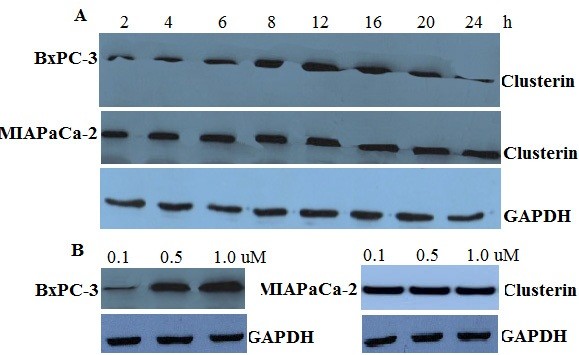
Induction of sCLU in a time and dose dependent fashion by gemcitabine treatment.A. Western analysis showing sCLU expression after 2–24 hours treatment with 0.5 nM gemcitabine. Induction of sCLU is evident in chemo-sensitive BxPC-3 cells when treated with high doses of gemcitabine but not in MIAPaCa-2, in which the high levels of sCLU remained unchanged. B. Western analysis showing sCLU expression in cell extracts after 12 hours treatment with 0.1-1.0 nM gemcitabine. sCLU increased in gemcitabine -sensitive BxPC-3 cells at different doses. At difference, expression of sCLU was unchanged in the MIAPaCa-2-resistant cells. The data shown are representative of three independent experiments.